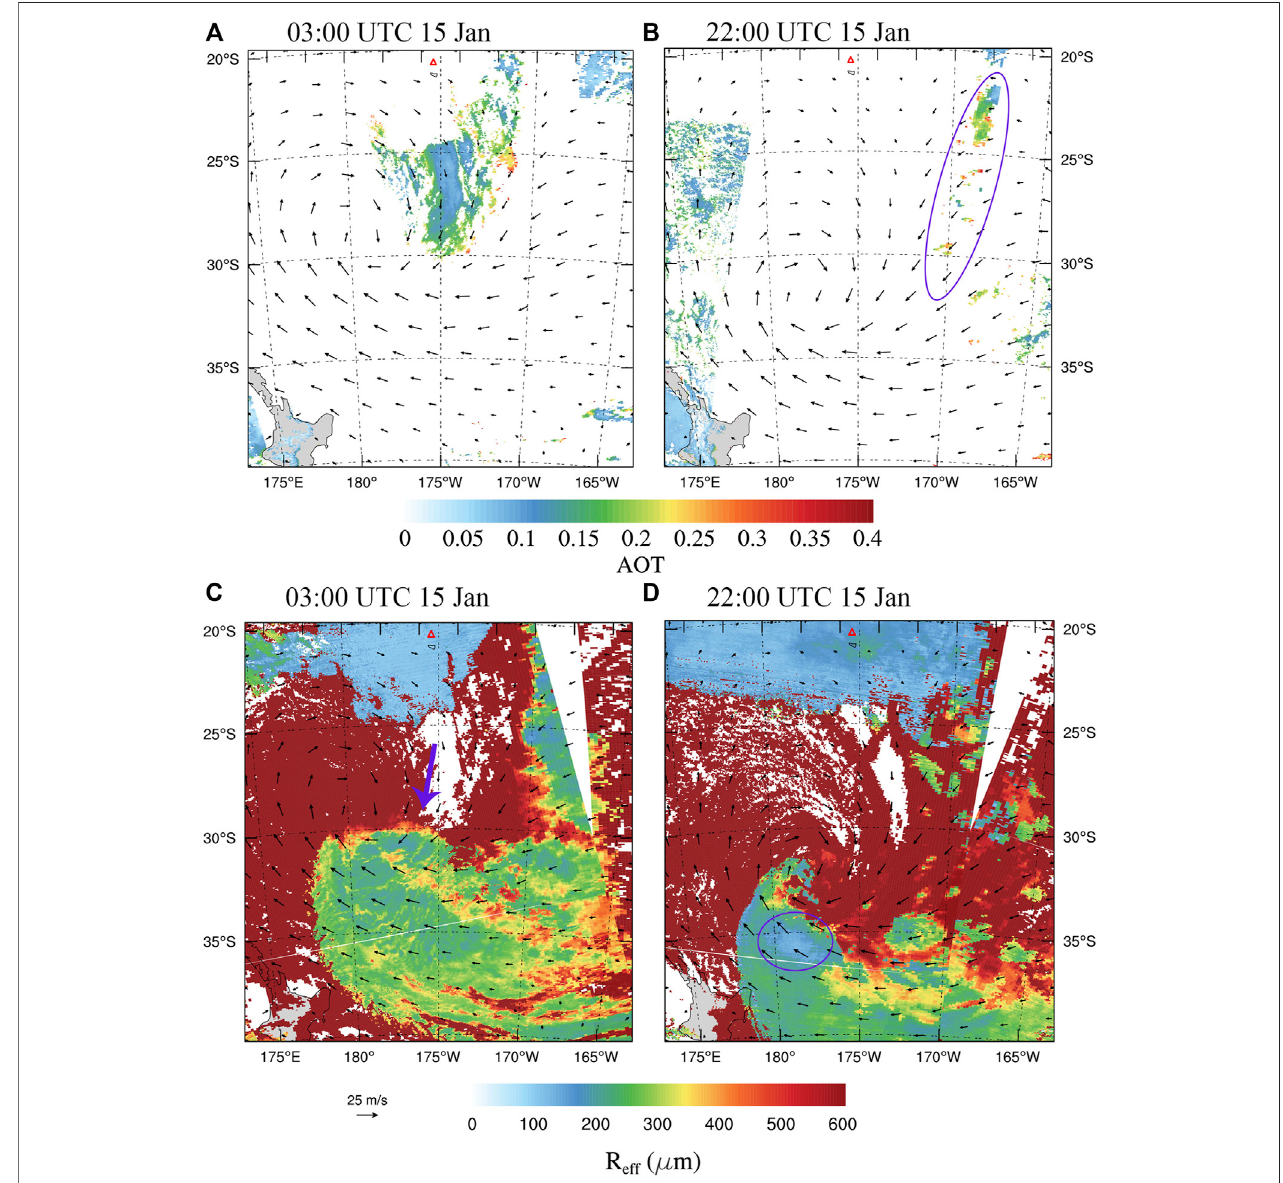
FIGURE 2 | MODIS observation with the wind fi eld at 10 m of EAR5 on January 15, 2022. (A,B) Aerosol optical thickness (AOT); (C,D) cloud particle effective radius.RedtrianglesindicatethelocationoftheTongavolcano,thepurplecirclein (B) showshigh-concentrationaerosolandthatin (D) showsdeepconvection,andthe purple arrow in (C) denoted the in fl ow with high-concentration